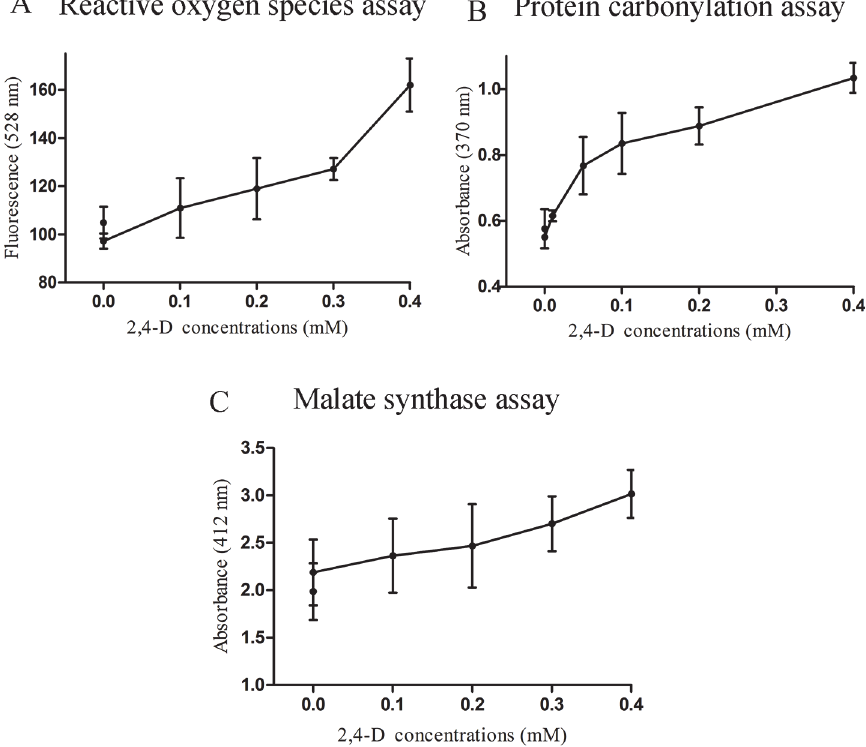
Fig 5. Assays of oxidative stress and glyoxylate metabolism with 2,4-D exposure show Rlv stress and adaptation. Plots show accumulation of reactive oxygen species (A), protein carbonylation (B) and malate synthase activity (C) as a function of 2,4-D exposure measured as ROS-sensitive DCFDA fluorescence intensity (528 nm), absorbance of dinitrophenyl hydrazone (370 nm) and absorbance of DTNB (412 nm), respectively. Absorbance values for the MS and PC assays were normalized with protein concentrations determined by Bradford assay. Data represent a minimum of three trials (p (cid:3) 0.05).